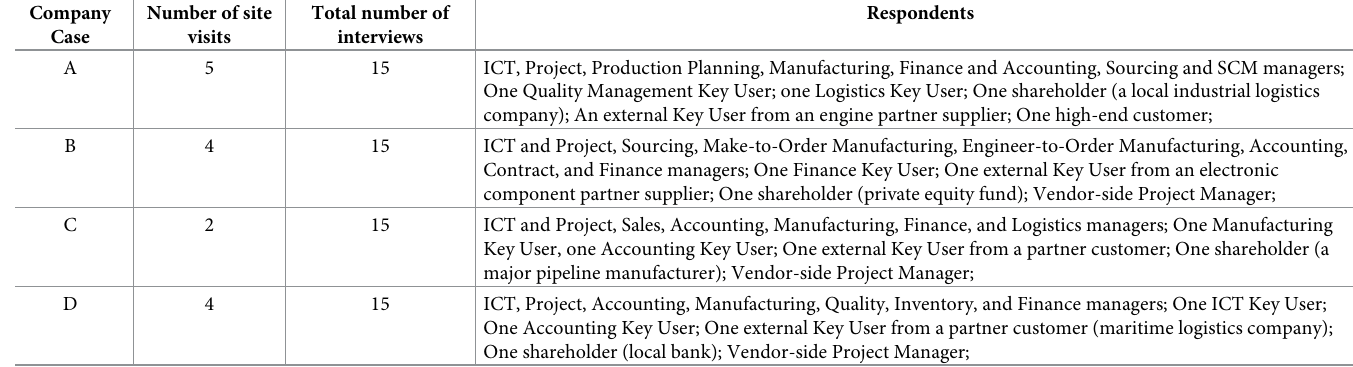
Table 3. Details on interviews and site visits.